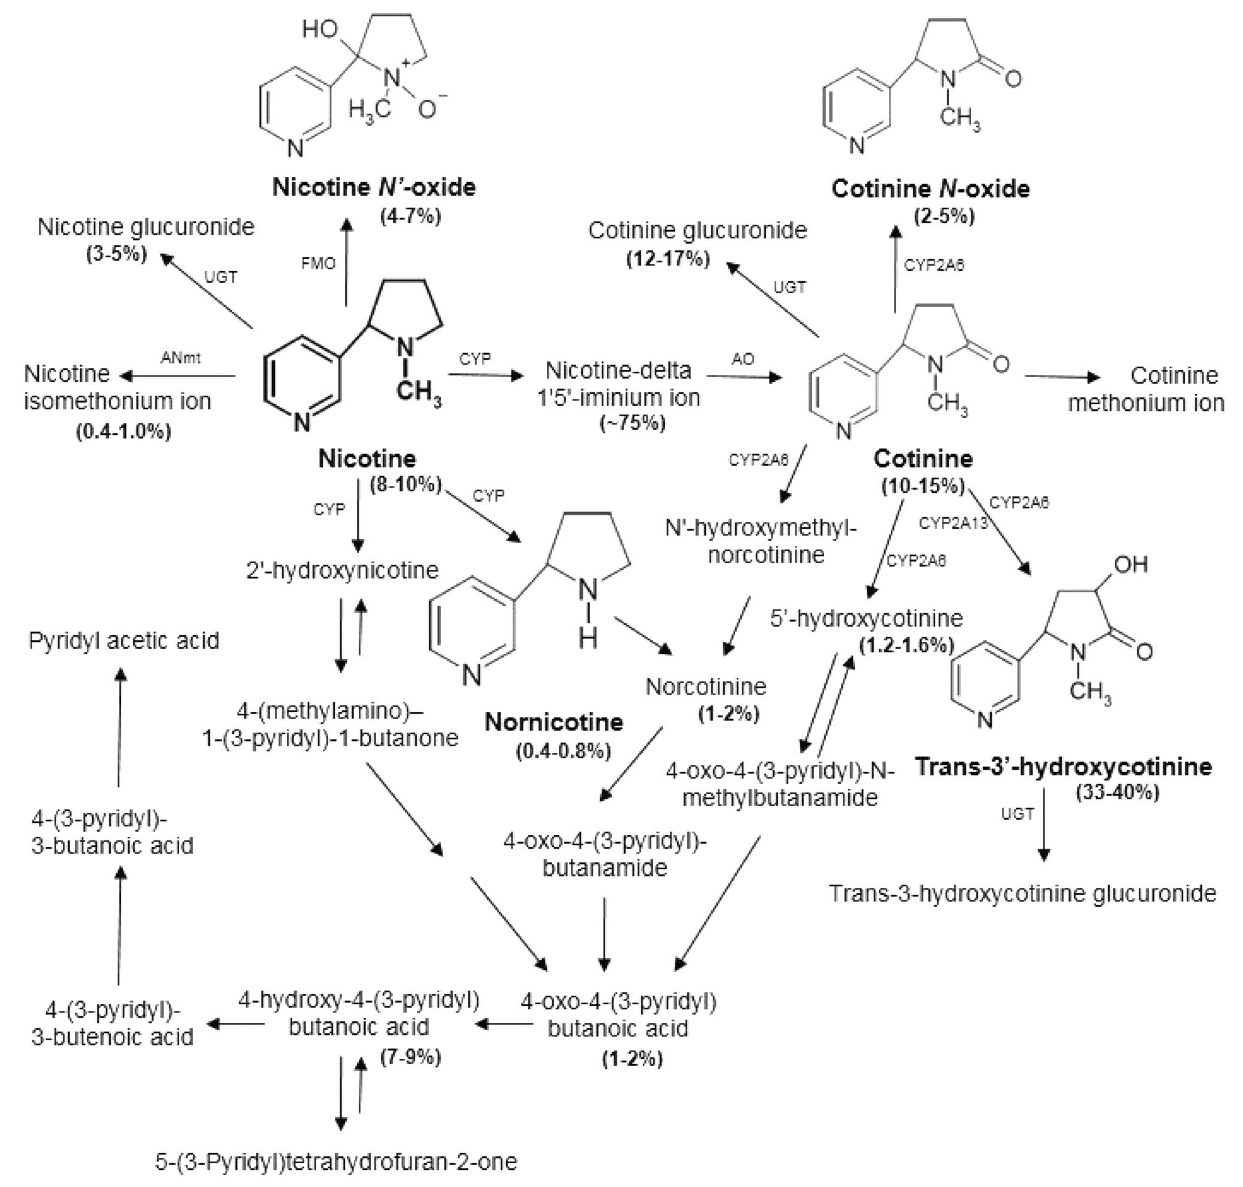
Figure 1. A scheme of quantitative nicotine metabolism, based on estimates of average excretion of metabolites as a percent of total human urinary nicotine. (%)—the percentage excreted in the urine of nicotine and its metabolites; CYP—cytochrome P450 enzymes; UGT—UDP-glucuronosyltransferase; FMO—flavin-containing monooxygenase; AO—aldehyde oxidase; ANmt—amine N-methyltransferase. A sheme based on publication data 19,26,27